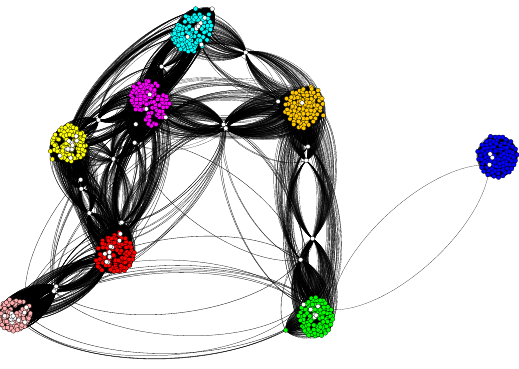
Figure 4. Visualization of the graph formed from the D2K8 dataset. Ground truth clusters are each represented by a separate